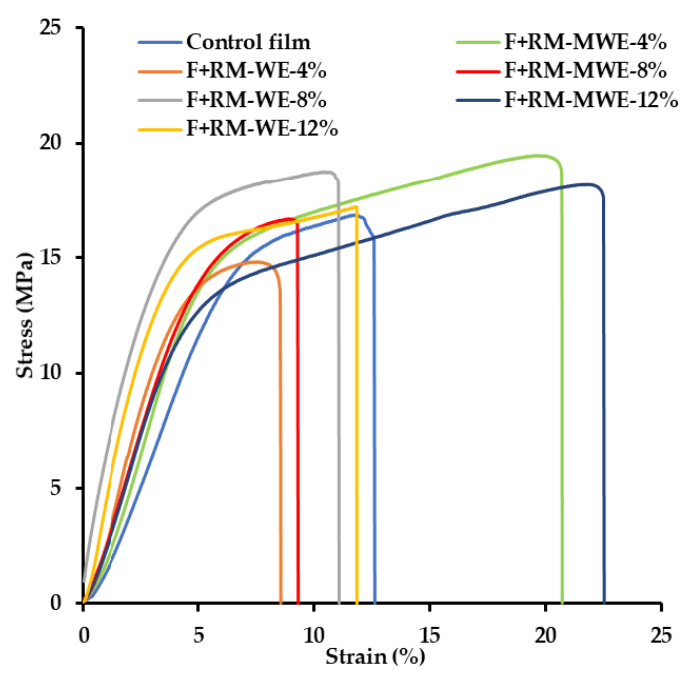
Figure 1. Representative stress–strain curves of the prepared films.